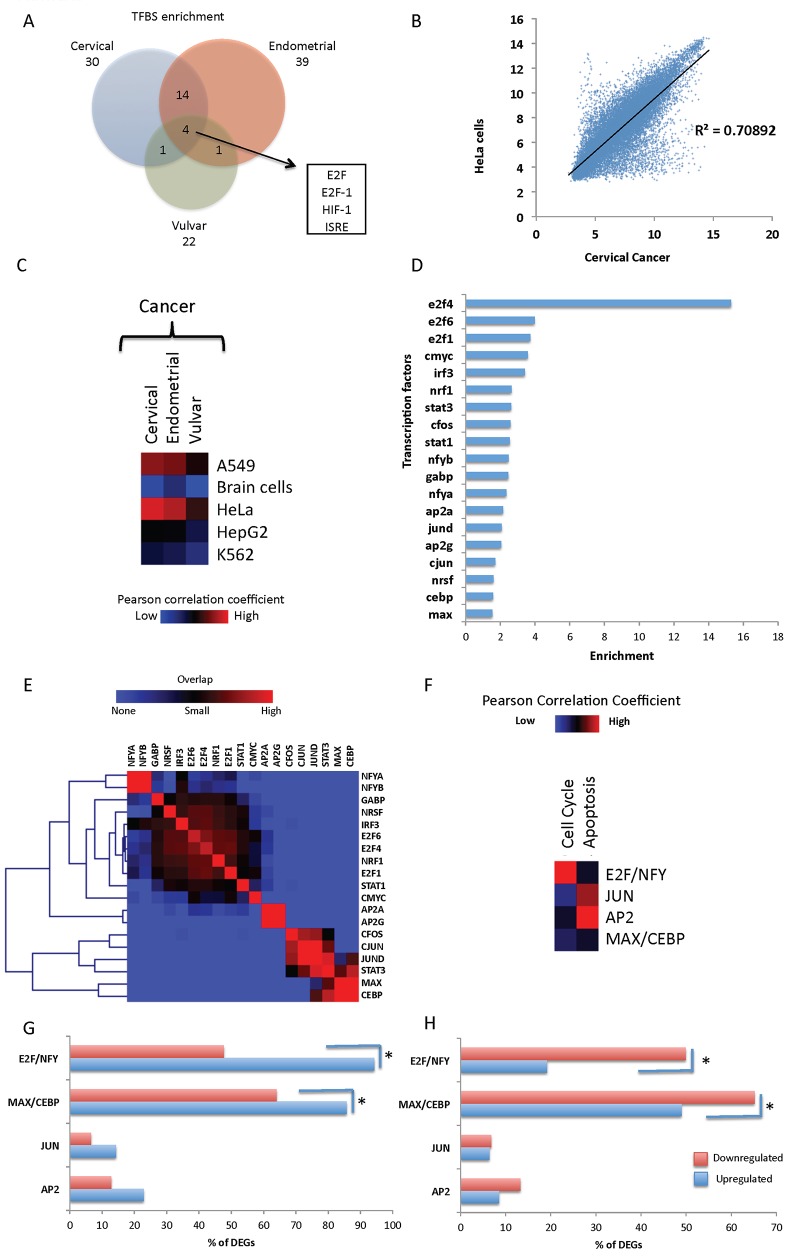
Identification, annotation of novel cervical cancer modules and comparison with embryonic stem cell modules using both in silico and in vivo studies (ENCODE) and correlation of module activity with apoptosis and cell cycle.A. Venn diagram of commonly transcription regulators found to be enriched near the TSS (-3000, +200 bp) of upregulated genes in each gynecological cancer. B. Scatter plot showing the correlation between the HeLa cell line and a cervical cancer array (r = 0.84). C. Heatmap of the correlation of the expression of all gynecological cancers and the corresponding normal samples, with the expression of HeLa, K562, A549, HepG2 and normal brain cells as calculated from more than three independent studies for each tissue or cell line. Accession numbers from all the studies are shown in S3 Table. D. Bar graph depicting the enrichment of annotated transcription regulators from ENCODE in HeLa cells in the upregulated genes in cervical cancer patients. E. Heatmap of transcription factor binding site overlap of transcription regulators enriched in cervical cancer upregulated genes (S4 Table). F. Heatmap showing the correlation of JUN and AP2 modules with apoptosis, and of E2F/NFY with cell cycle regulation. G. Bar graphs of the correlation of E2F/NFY and MAX/CEBP modules with Myc module for upregulated genes. H. Bar graphs of the correlation of E2F/NFY and MAX/CEBP modules with Prc module for downregulated genes.